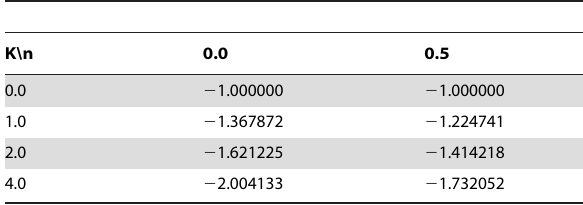
Table 3. Comparison of h (0) and { h 0 (0) for different values of Pr when K ~ 0 and c ~ 1 for NH case.